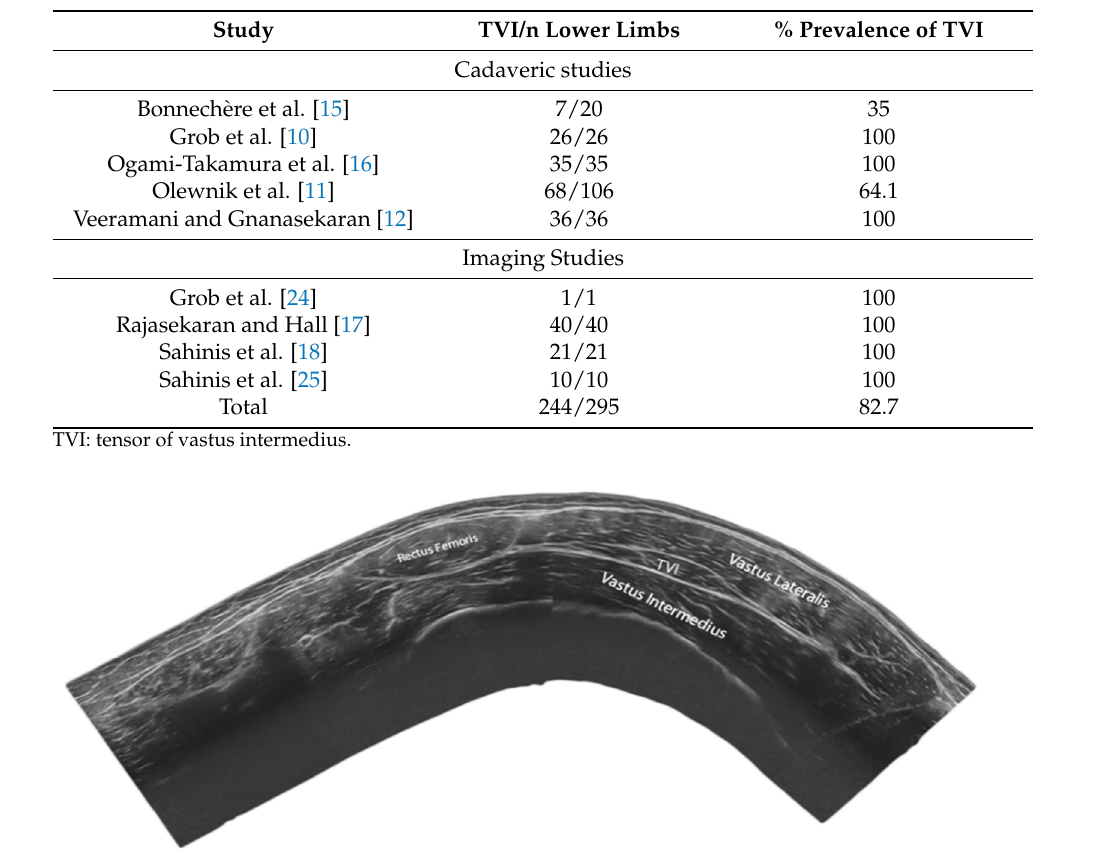
Table 2. Prevalence of tensor of the vastus intermedius between the studies.